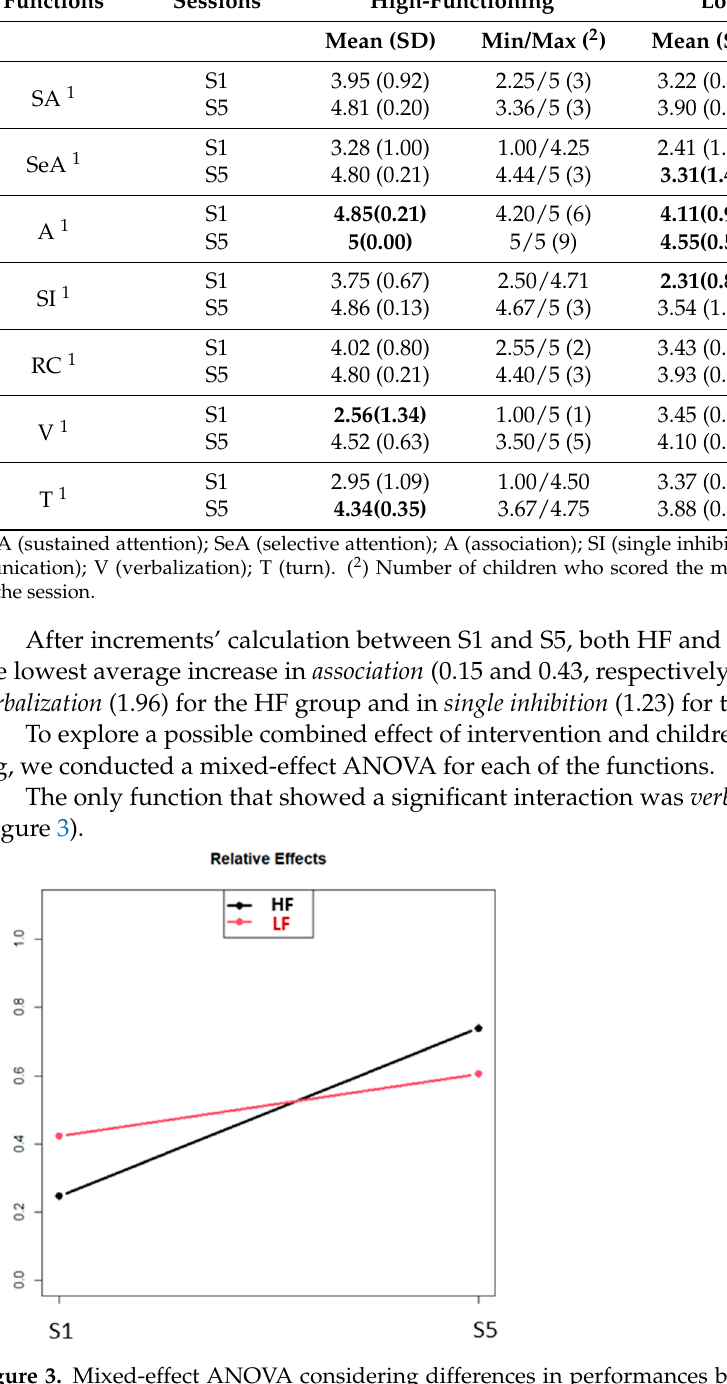
Figure 3. Mixed-effect ANOVA considering differences in performances between S1 and S5 and functioning level (HF vs. LF) in the children’s